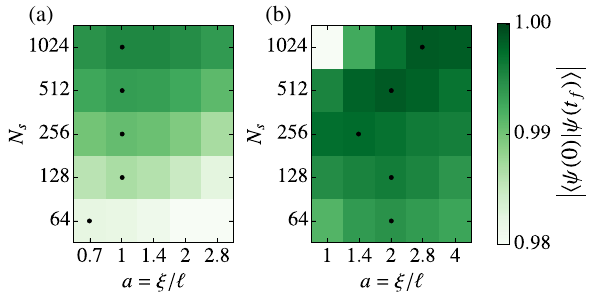
FIG. 7. Finite-size scaling for the numerical simulations. (a) Scalar product jh ψ ð 0 Þj ψ ð T= 2 Þij for an initial triangular shape. The size of the grid N and the sampling of the healing length s a ≡ ξ = l are varied. The highest value is 0.9953 obtained for ¼ 1024 , a ¼ 1 . (b) Scalar product jh ψ ð 0 Þj ψ ð 2 T Þij for an N s initial disk shape. The highest value is 0.9986 obtained for ¼ 1024 , a ¼ 2 . 8 . On both figures, the black dots indicate the N s highest value of the scalar product for each